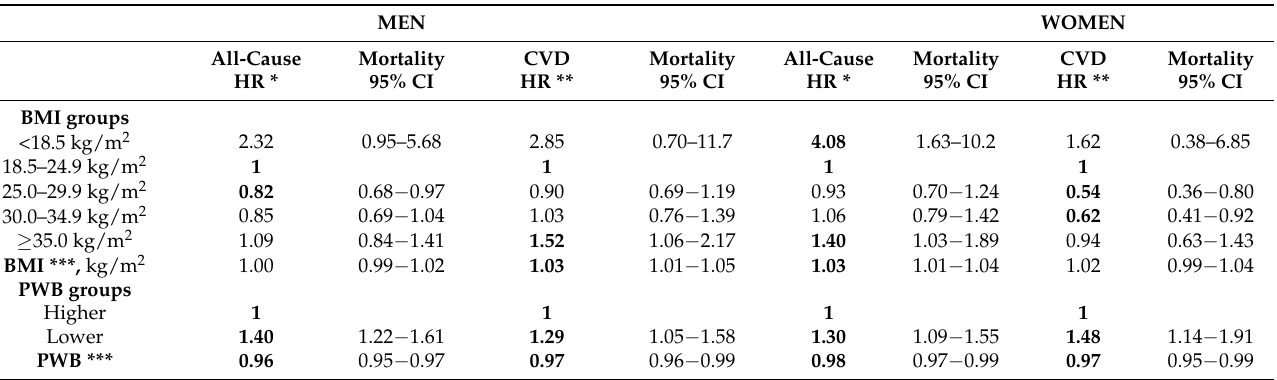
Table 3. All-cause and CVD mortality risk for BMI and PWB groups according to gender (follow–up for endpoints period mean (SD) 12.6 (2.79)